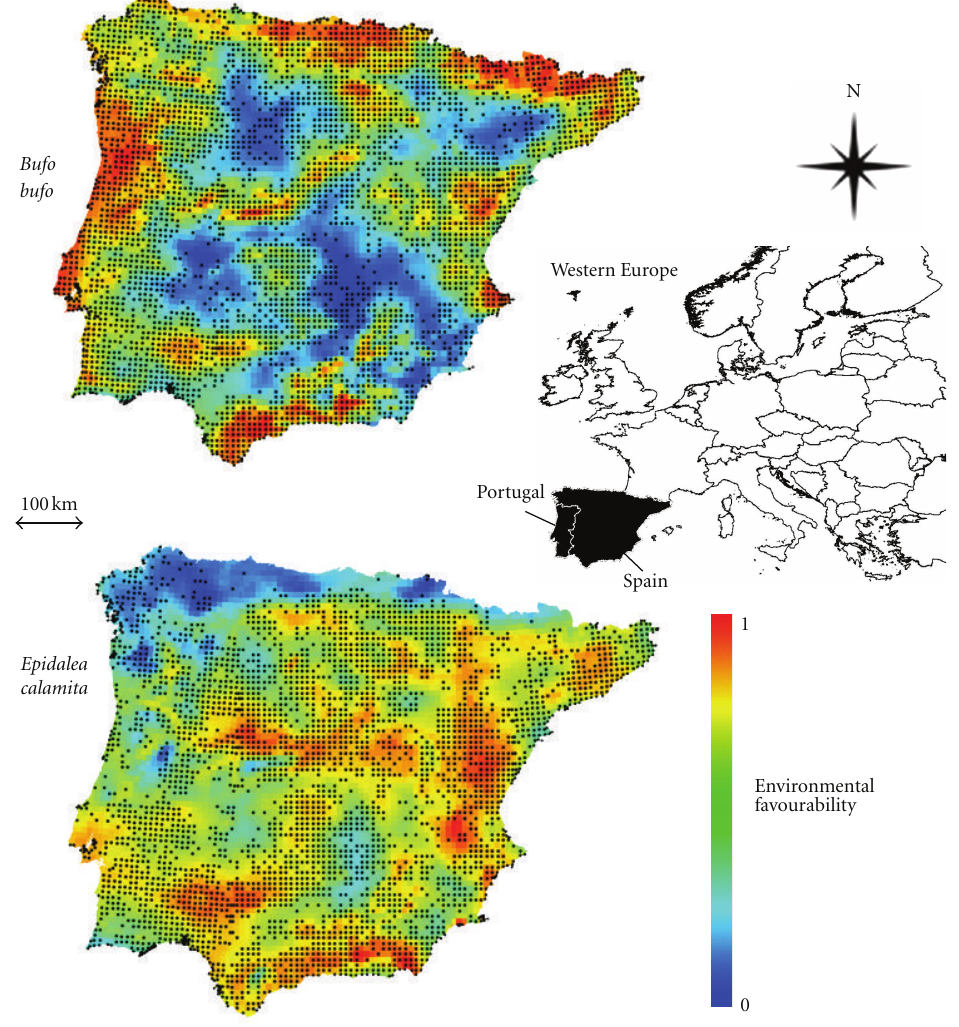
Figure 1: Location of the study area, recorded distributions (black dots: presences on UTM 10 × 10km squares, after Loureiro et al. [10] for Portugal and Pleguezuelos et al. [1] for Spain), and environmental favourability values predicted for Bufo bufo and Epidalea calamita across the Iberian